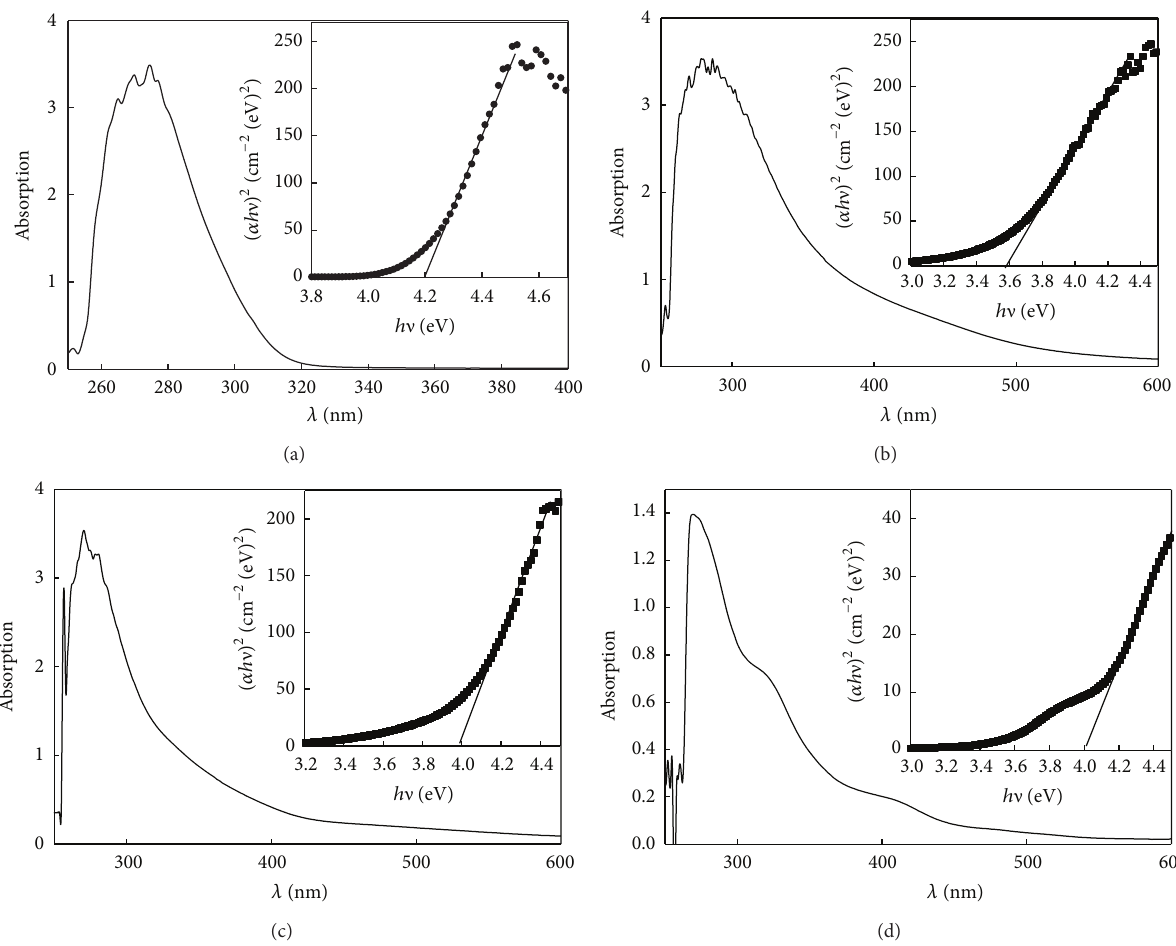
Figure 3: Absorption spectra of (a) synthesized ligand LH and its complexes (b) L 2 Co, (c) L 2 Cu, and (d) L 2 Ni at room temperature.